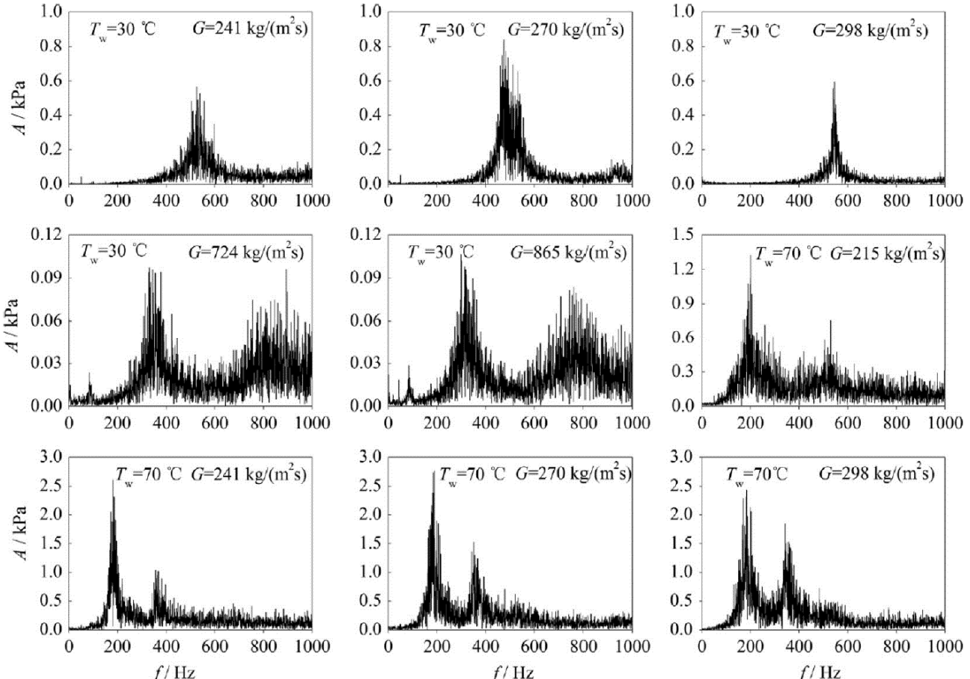
Figure 31. Pressure pulsation frequency at different operating conditions [94].